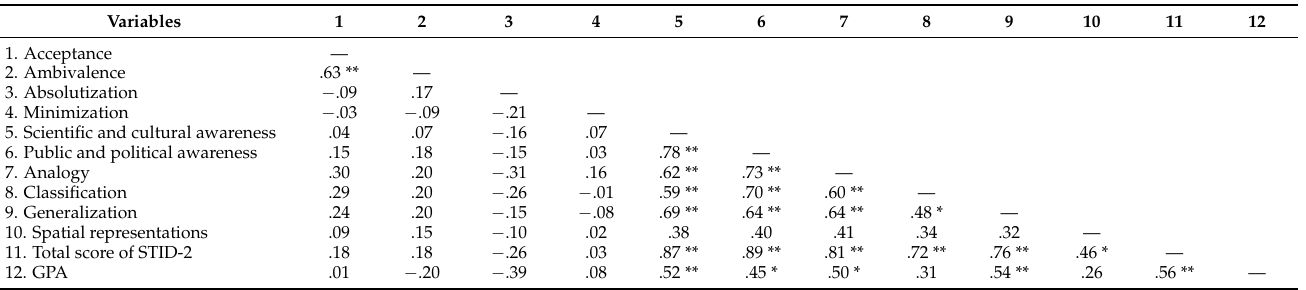
Table 3. Spearman’s correlations between studied variables in the sample of male school students ( N = 51).